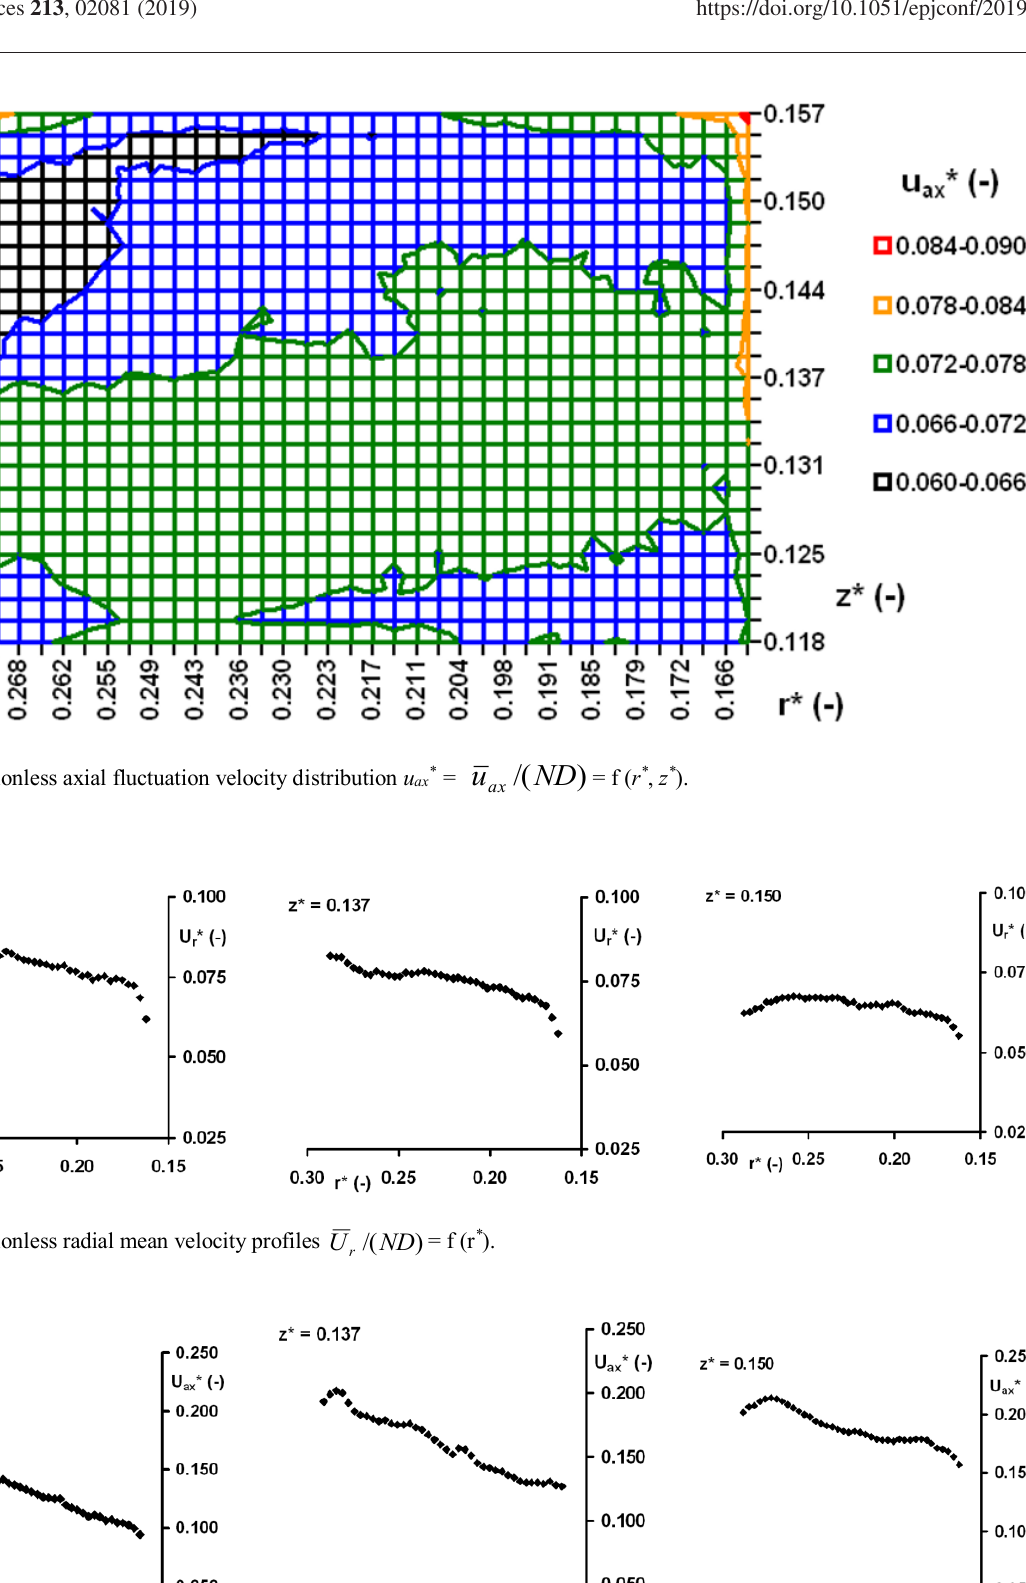
Fig. 7. Dimensionless axial mean velocity profiles )/( NDU